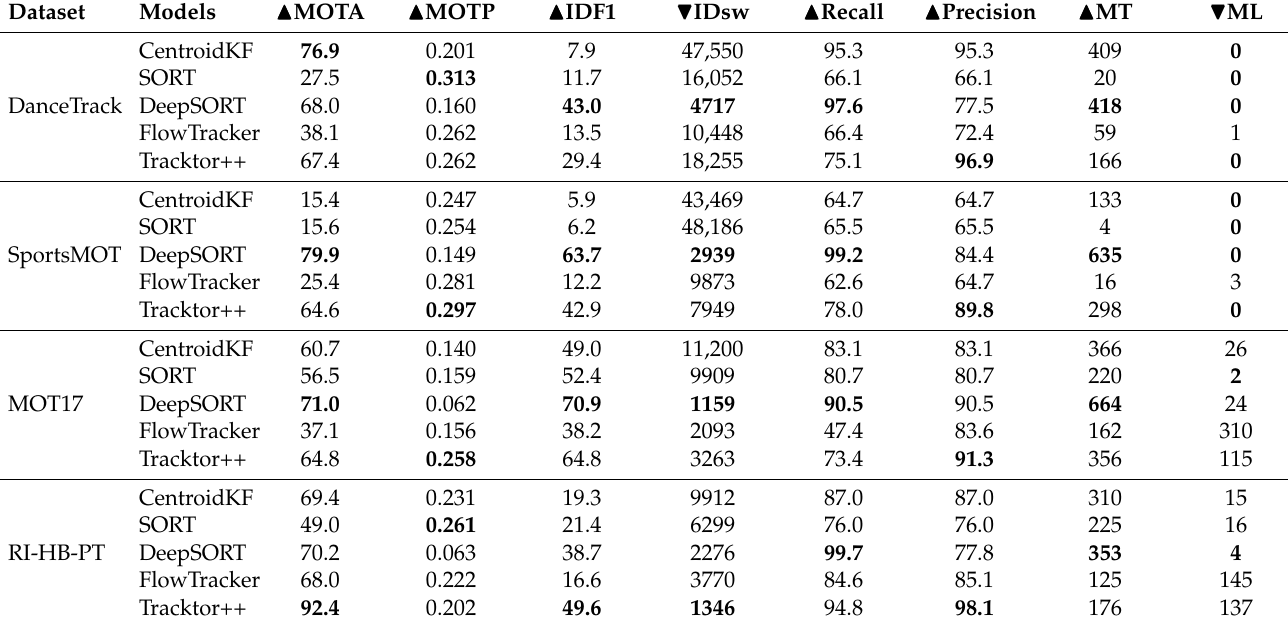
Table 6. Results of tracking methods on DanceTrack, SportsMOT, MOT17, and a custom RI-HB-PT dataset of players practicing various handball actions during a practice session. The best results according each metrics are marked in bold. Metrics are computed as described in Section